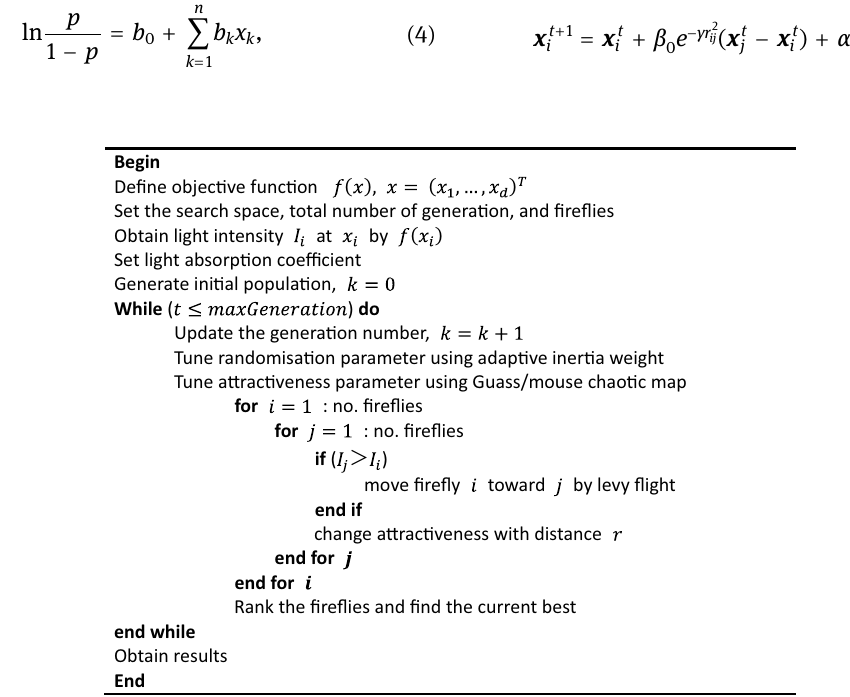
Figure 8: The pseudocode of